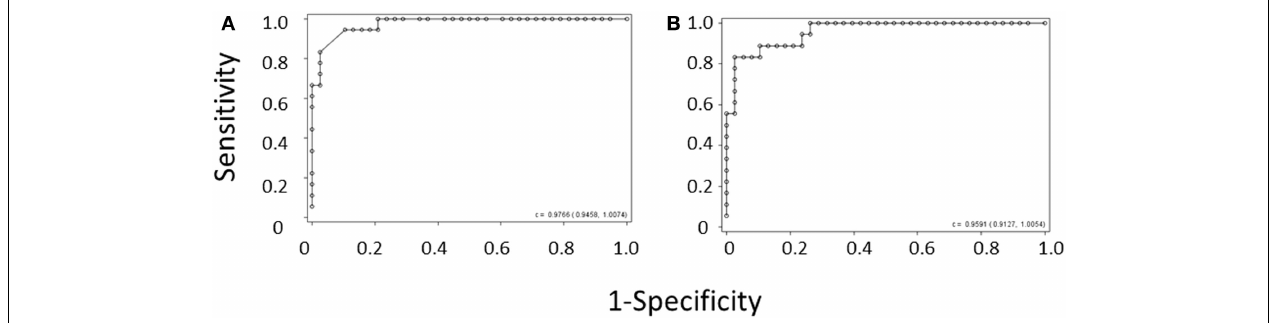
FIGURE 2 | ROC curve derived from (A) the MPV rule or (B) the IPF/PLT rule in the derivation cohort . Each open circle marks the sensitivity and specificity of a given MPV cutoff. C-statistics appear in the lower right-hand corners of the graphs.